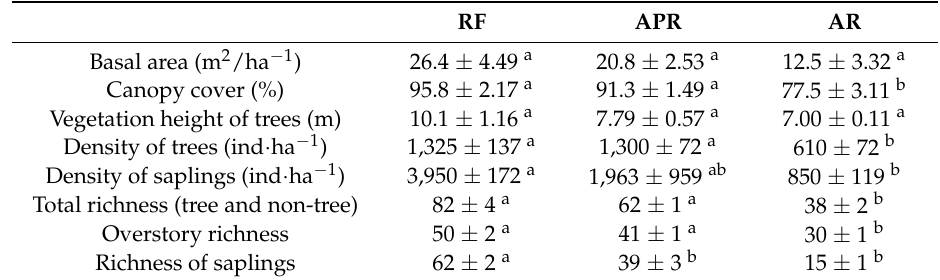
Table 1. Mean vegetation attributes ( ± standard error, n = 4) sampled in the forest stands. Different superscript letters denote statistically significant differences between land use types, according to the Tukey’s test ( p < 0.05), except for the basal area and vegetation height of trees where Kruskal–Wallis test ( p < 0.05) was applied. RF, Reference Forest; APR, Assisted Passive Restoration; AR, Active Restoration; LiP, Low-intensity Pasture; HiP, High-intensity Pasture. RF APR